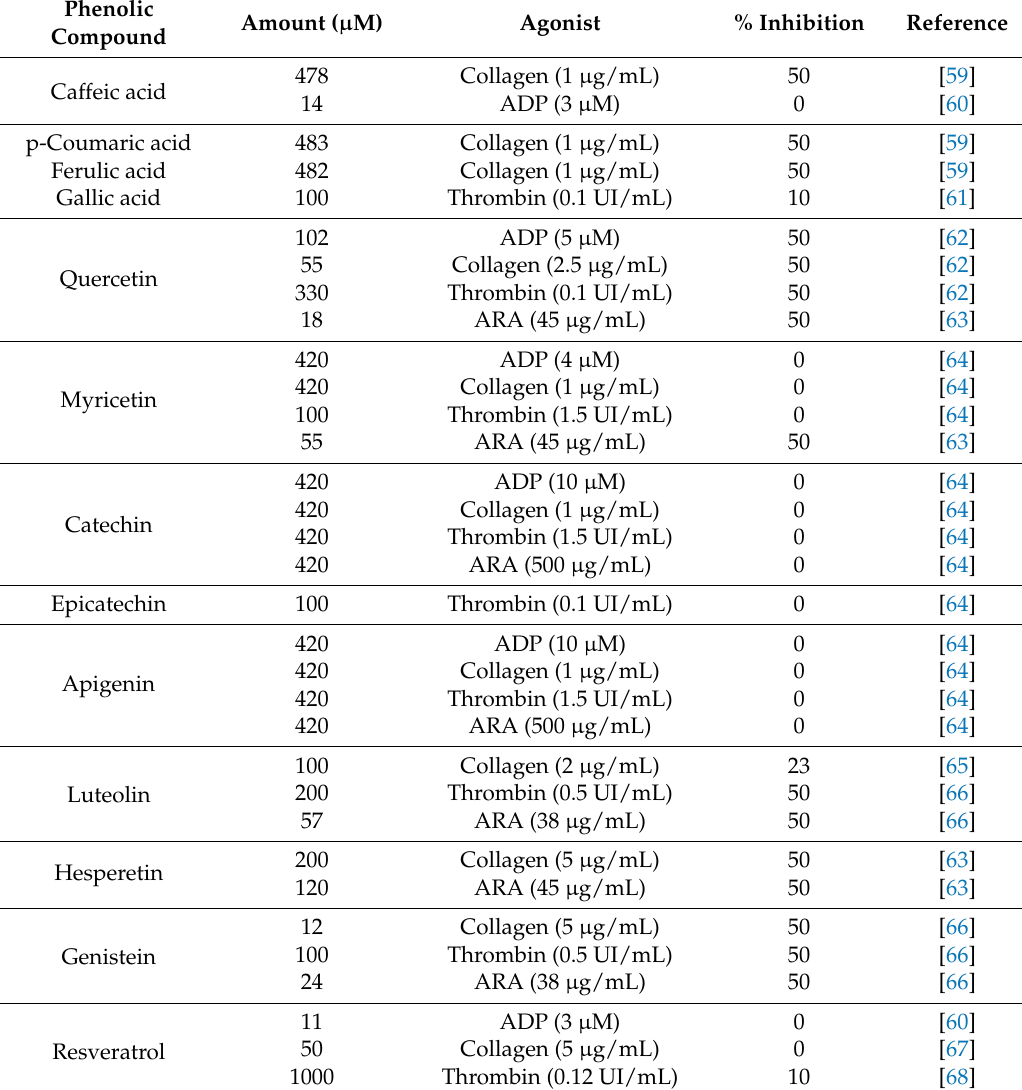
Table 1. PC affecting platelet aggregation induced by different